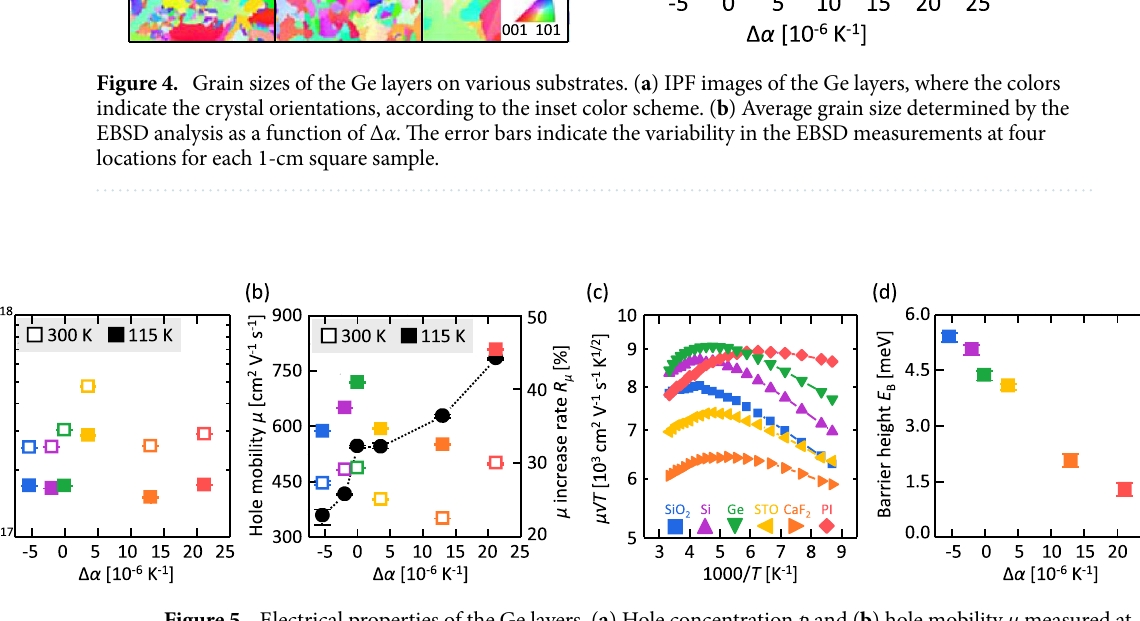
Figure 5. Electrical properties of the Ge layers. ( a ) Hole concentration p and ( b ) hole mobility μ measured at T = 115 K and 300 K as functions of Δ α . The μ increase rate R μ is also shown in ( b ). ( c ) Arrhenius plots of μT 1/2 for various substrates. ( d ) Grain boundary barrier height E B as a function of Δ α . The error bars indicate the variability in the five measurements for each